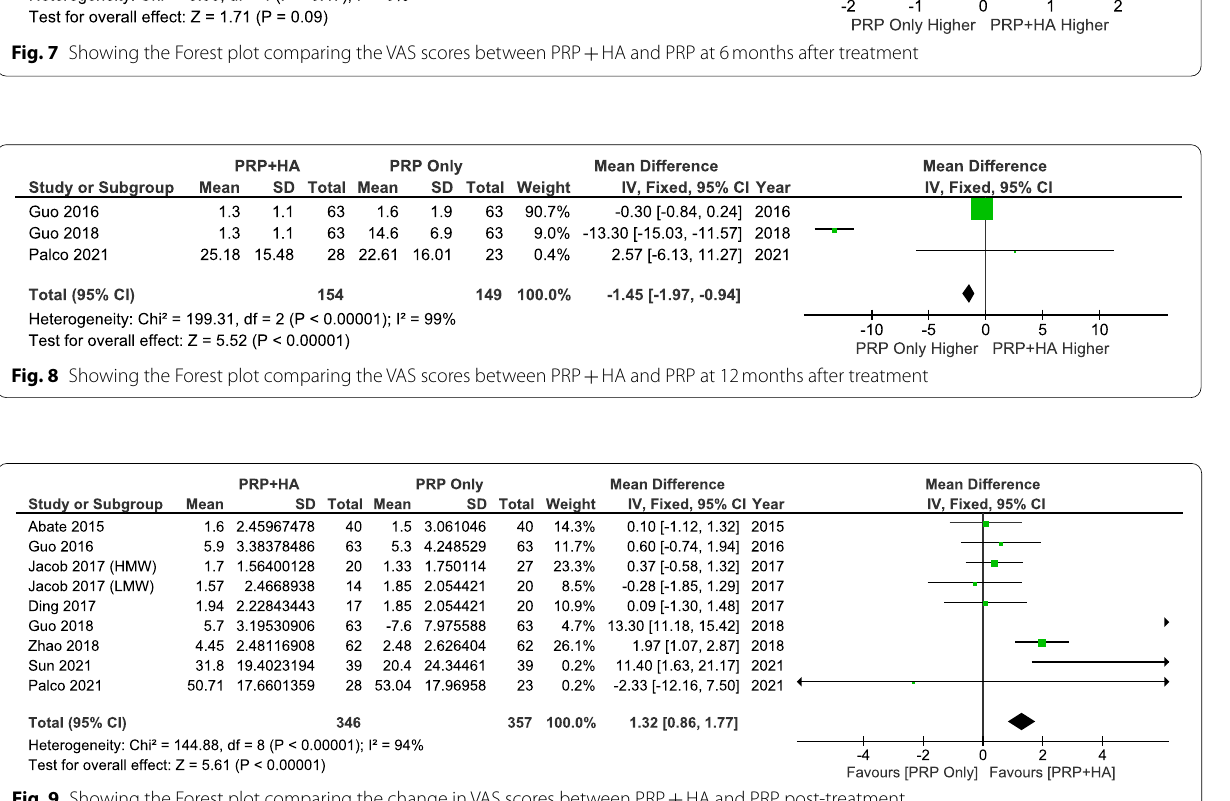
IKDC scores between the groups (SMD: 0.34, 95% CI: 3.21 to 3.89, P 0.85 n.s.) (Fig. 15). − = = A total of 3 studies reported IKDC scores at 6 months after treatment. The results showed patients who received PRP combined with HA had significantly better IKDC